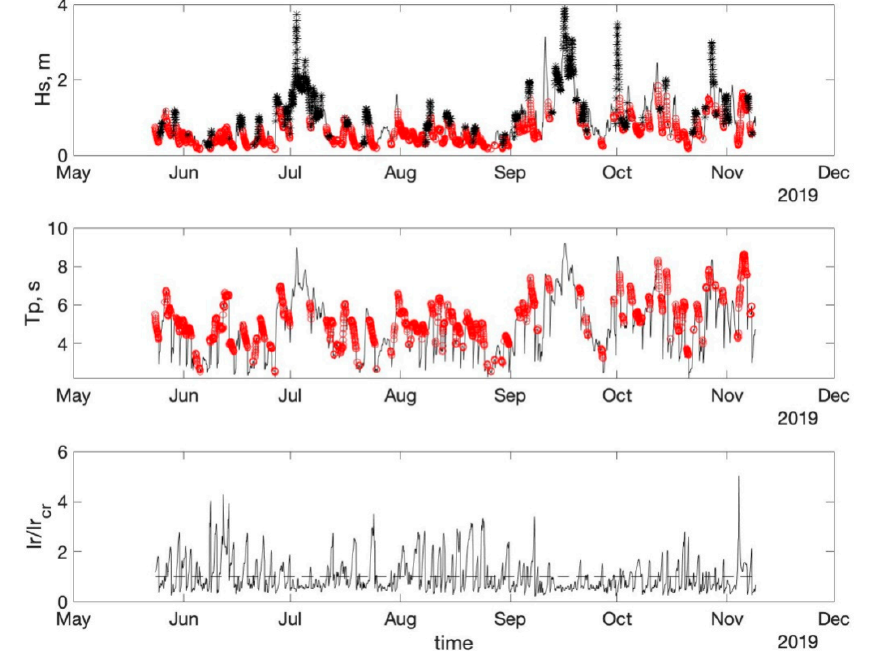
Figure 5. Wave height, peak wave period and ratio between deep water and critical Iribarren number (below the dashed line are regimes with pronounced exchange of energy between wave harmonics). Red circles—wave regimes without pronounced energy exchange between harmonics. Black stars—shore-normal